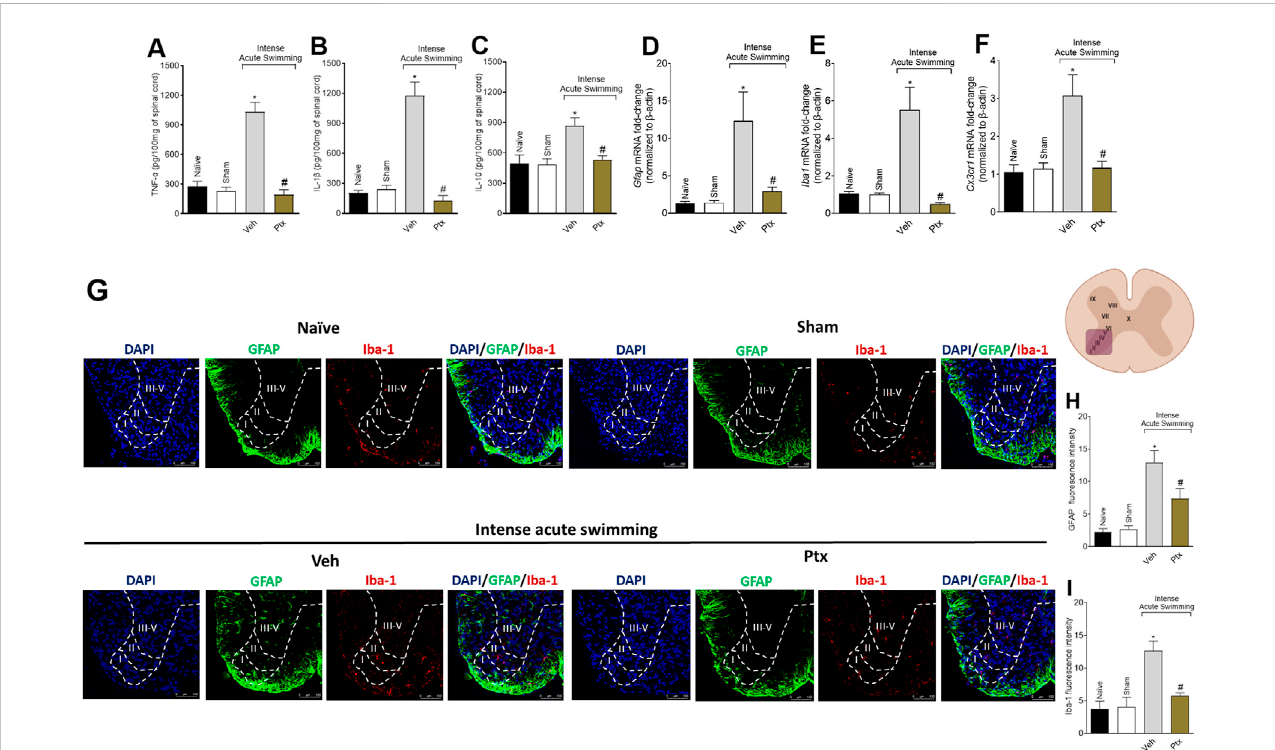
FIGURE 3 Ptxreducescytokineproductionandglialcellactivationinthespinalcord.Ptx(4.5 mg/kgdose;i.p.)inhibitsintenseacuteswimming – induced (A) TNF- α , (B) IL-1 β , and (C) IL-10 protein levels; (D) Gfap, (E) Iba1, and (F) Cx3cr1 mRNA expression; and GFAP (G,H) and (G,I) Iba-1 immuno fl uorescence intensity in the spinal cord. Boundaries of dorsal horn laminae (I – V) were delineated to better clarify the regions of staining. An illustration of the spinal cord in the right denotes the areas in which staining was quanti fi ed during the experiments. Results are presented as picograms per 100 mg of the spinal cord for cytokines, as the spinal cord mRNA fold-change normalized to β -actin for glial markers mRNA expression ( n = 6 mice per group per experiment and is representative of two independent experiments), and as fl uorescence intensity for glial protein expression ( n = 4 mice per group per experiment and is representative of two independent experiments; scale bars: 100 µm for the inserts). * p < .05 when compared with control groups, # p < .05 when compared with Veh group (one-way ANOVA followed by Tukey ’ s post hoc